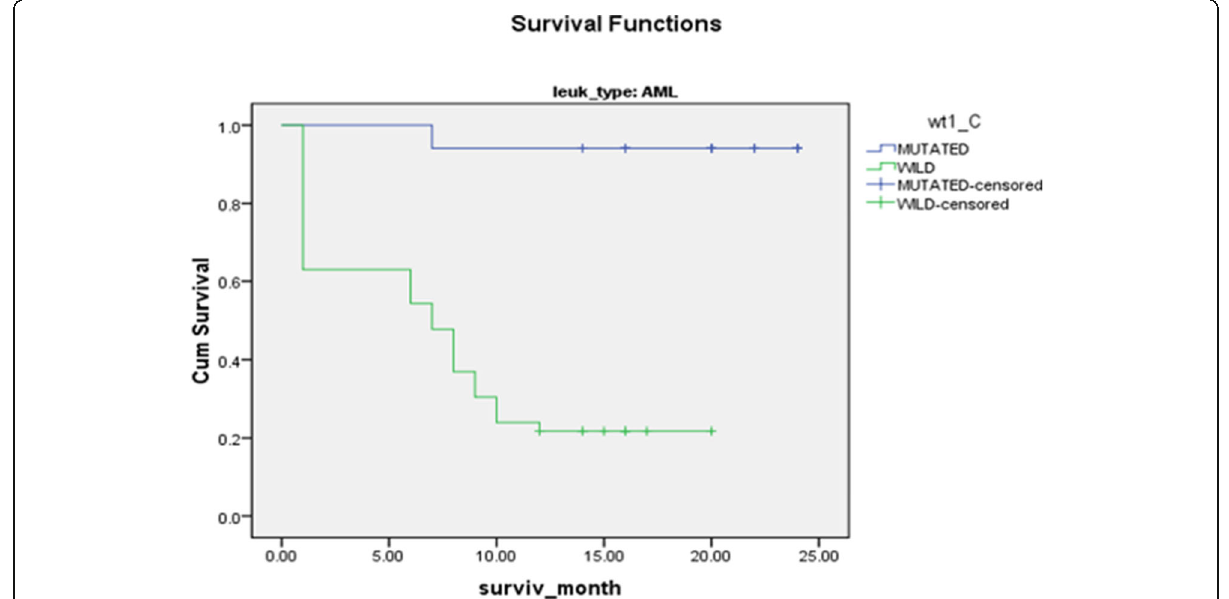
Fig. 1 Kaplan-Meier survival curve in AML patients with wild and mutant WT1